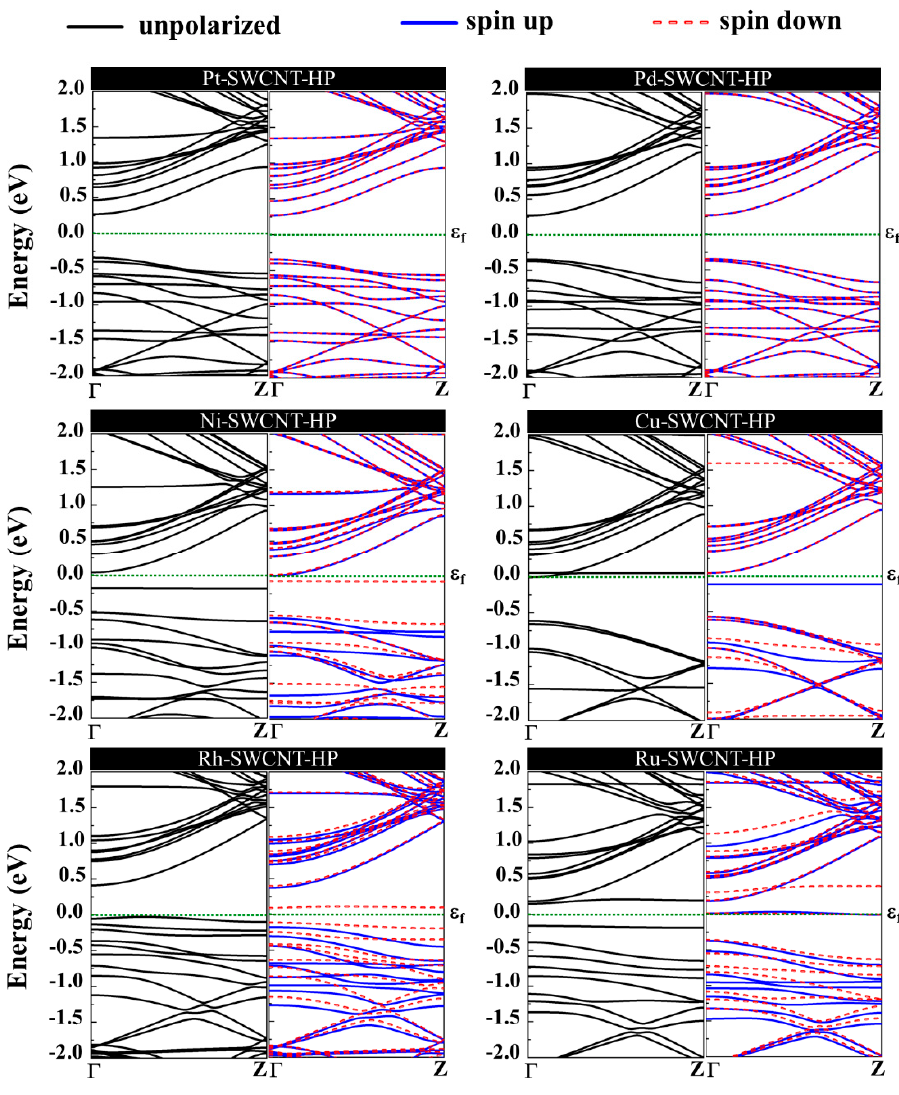
Figure 10. Energy band structures of H 2 O 2 adsorption on Pt-SWCNT, Pd-SWCNT, Ni-SWCNT, Cu-SWCNT, Rh-SWCNT, and Ru-SWCNT systems. The dotted green line indicates the Fermi level, which is set to zero.